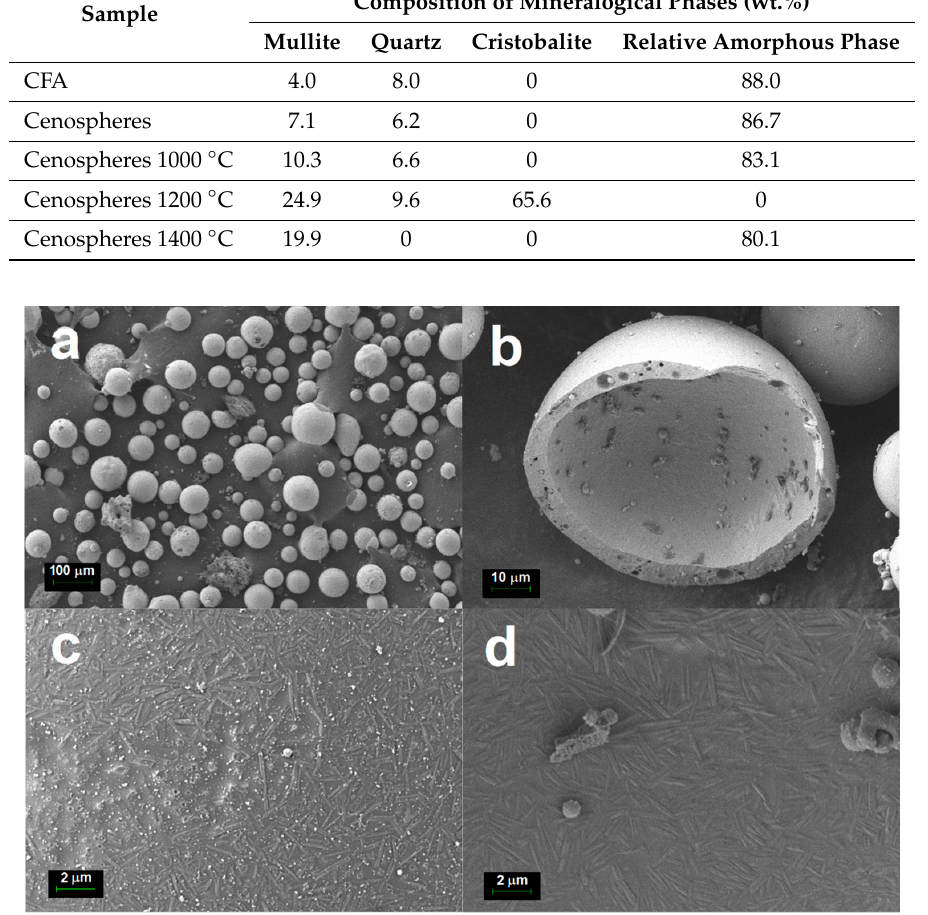
Figure 3. FESEM images showing the ( a ) size distribution of the cenospheres particles ( b ) cross-section and ( c ) outer surface and ( d ) inner surface of a single cenosphere particle in closer views. The XRD results showed that cristobalite formation started at a temperature below 1200